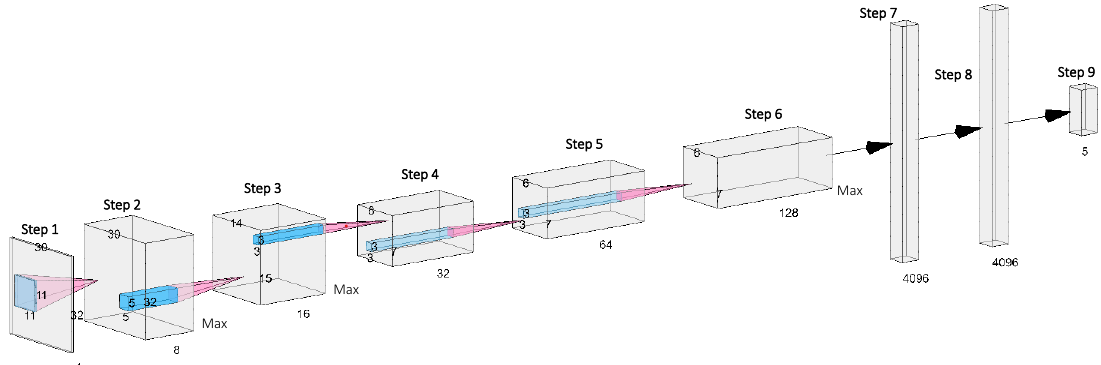
Figure 5. The proposed Convolutional Neural Network (CNN) architecture. Step one represents the image input layer, steps two to six represent the convolutional layers and their intervening pooled and normalisation layers and steps seven to nine show the fully connected layers. The cross-channel normalisation, batch normalisation, Rectified Linear Unit (ReLU) and dropout layers are not depicted here.